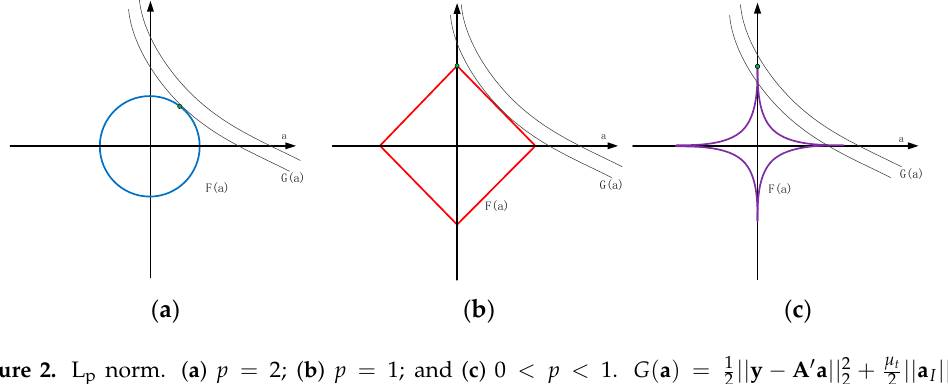
Figure 2. L p norm. ( a ) p = 2; ( b ) p = 1; and ( c ) 0 < p < 1. G ( a ) = 1 2 || y − A F ( a ) = λ || a || p p